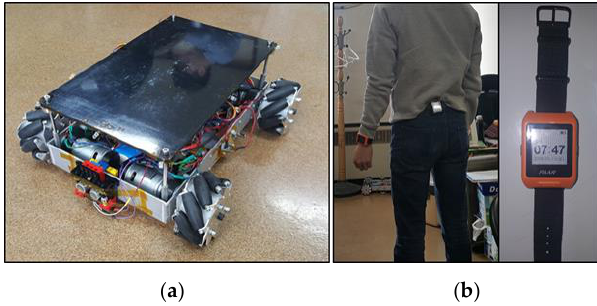
Figure 15. Prototypes of a mobile robot system: ( a ) mobile robot and ( b ) wearable devices (smart belt and watch).